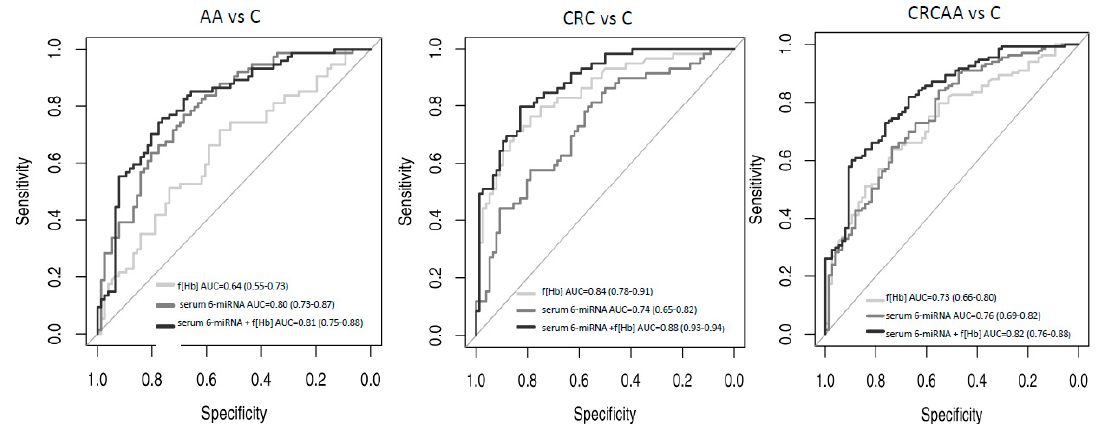
Figure 2. Receiver operating characteristic (ROC) curves of a serum 6-miRNA signature (miR-19a-3p + miR-19b-3p + miR-335-5p + miR-29a-3p + miR-15b-5p + miR-18a-5p) adjusted by age and gender, based on qRT-PCR results. Illustrating the FIT value alone, the 6-miRNA signature alone, the faecal haemoglobin concentration (f(Hb)) alone and the combination of 6-miRNA signature + f(Hb). Left: patients with advanced adenomas (AA) versus controls, middle: colorectal cancer (CRC) patients versus controls, right: patients with advanced colorectal neoplasia (CRC or AA) versus controls.